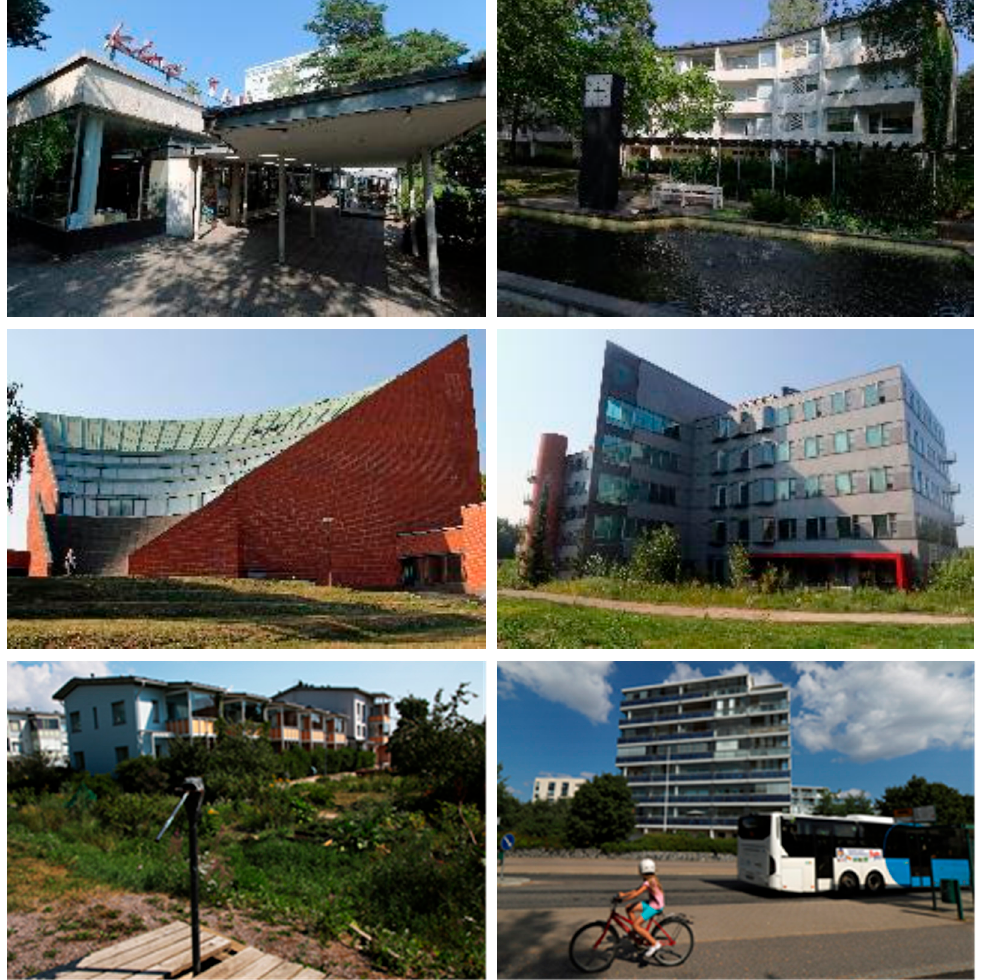
Figure 1. Top row: Tapiola Garden City, the first centre and housing developments from the 1950s. Middle row: Otaniemi High-Tech Campus, Undergraduate Centre (left) designed by Alvar Aalto and nowadays part of Aalto University, and Technopolis Innopoli 1 office park (right). Bottom row: Eco-Viikki. (All photos: Pekka Huovila).